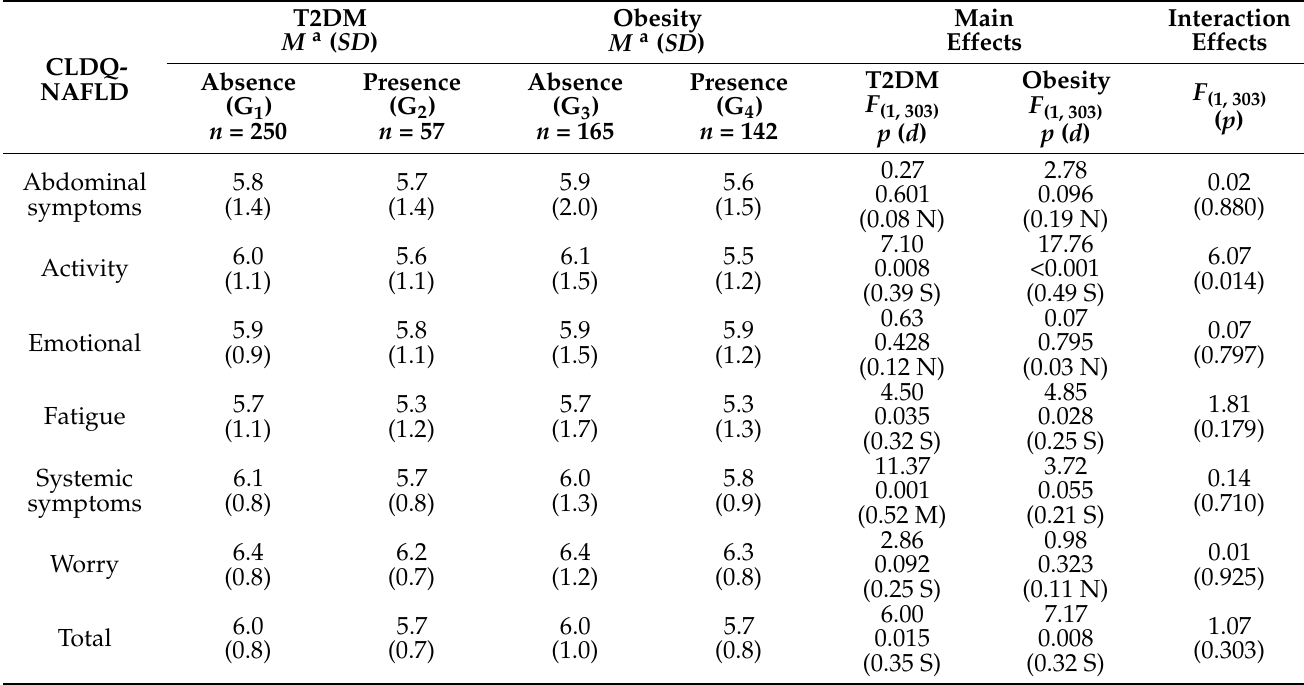
Table 3. Quality of Life (CLDQ-NAFLD) of Patients with NAFLD by T2DM (Absence and Presence) and Obesity (Absence and Presence) Variables.